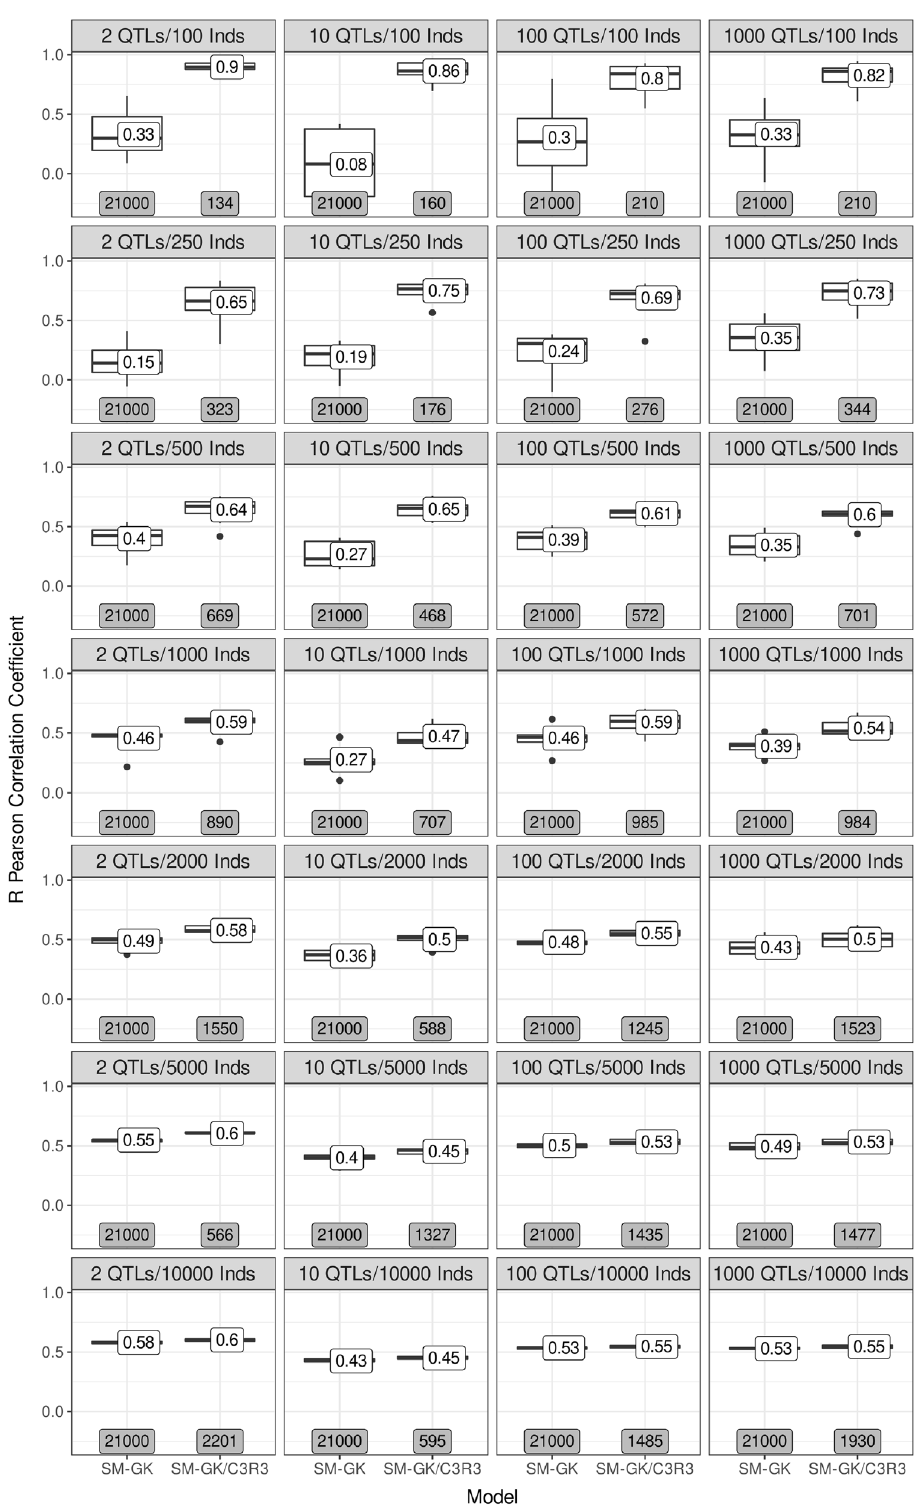
Figure 4. Accuracies of simulation scenarios created using a wheat breeding program and different quantities of QTLs per chromosome (2, 10, 100, and 1000). From 20 years of phenotypic selection (10 years of burn-in), preliminary yield trials (1000 lines) were selected by year, forming a dataset of 10,000 genotypes, which was sampled for different quantities of individuals (100, 250, 500, 1000, 2000, 5000, and 10,000) to perform 10-fold cross-validation using a single-environment main genotypic effect model with a Gaussian kernel (SM-GK) with and without the inclusion of the established feature selection approach (SM-GK/C3R3). The values in the boxplot labels represent the mean accuracy, and in the gray boxes the quantity of markers used to create the predictive